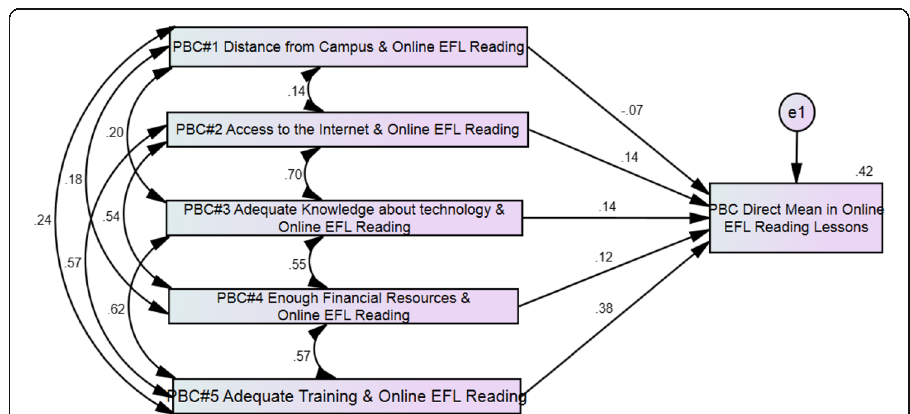
Fig. 2 Diagram of PBC indirect measures for the OLL